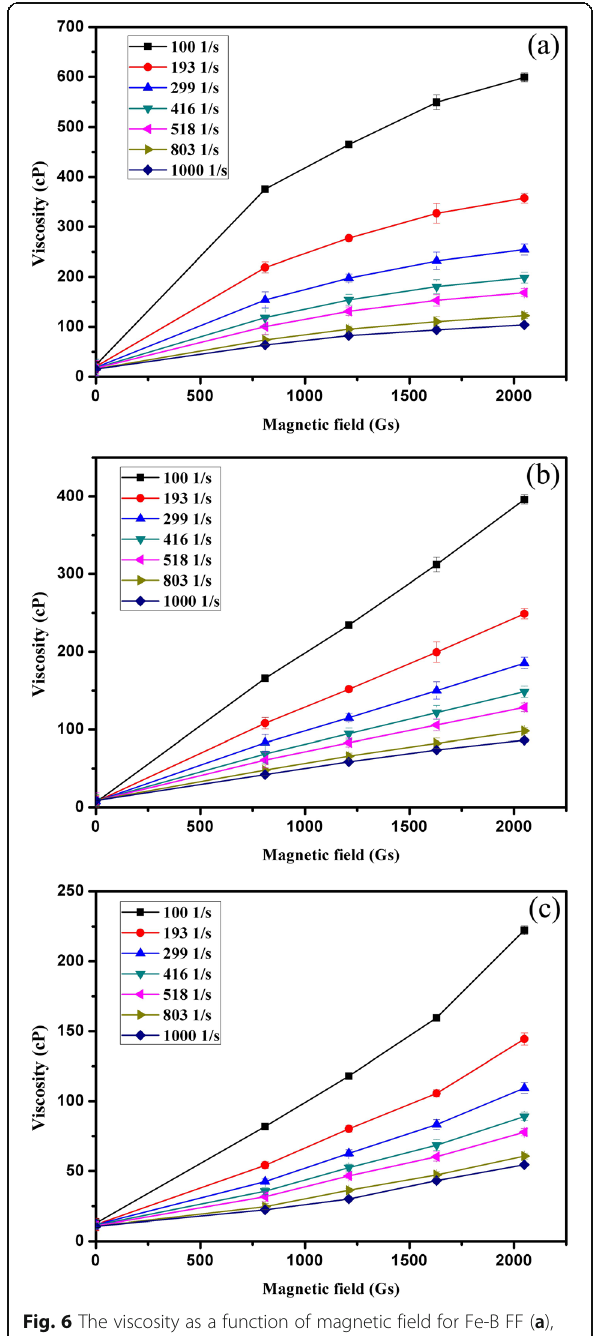
B FF ( b ), and Co-B FF( c )